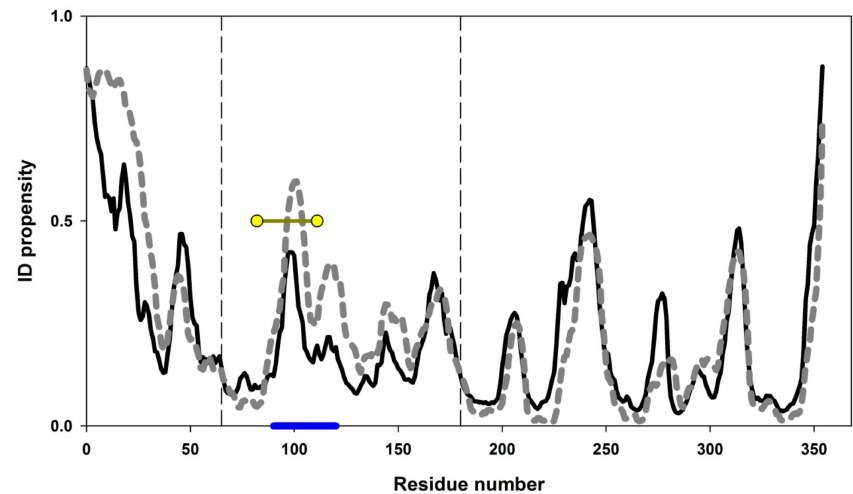
Figure 9. Intrinsic disorder propensities for amino acid sequence of G α o from D. melanogaster . The plots were calculated in PONDR ® FIT (solid line) and IsUnstruct (dashed line). Vertical dashed lines highlight the amino acid sequence region (65–180) forming domain II of G α o. Blue line under the plot shows the region to be stabilized by disulfide bond introduction. Yellow circles show the exact positions of amino acid residues, between which the disulfide bond was designed.